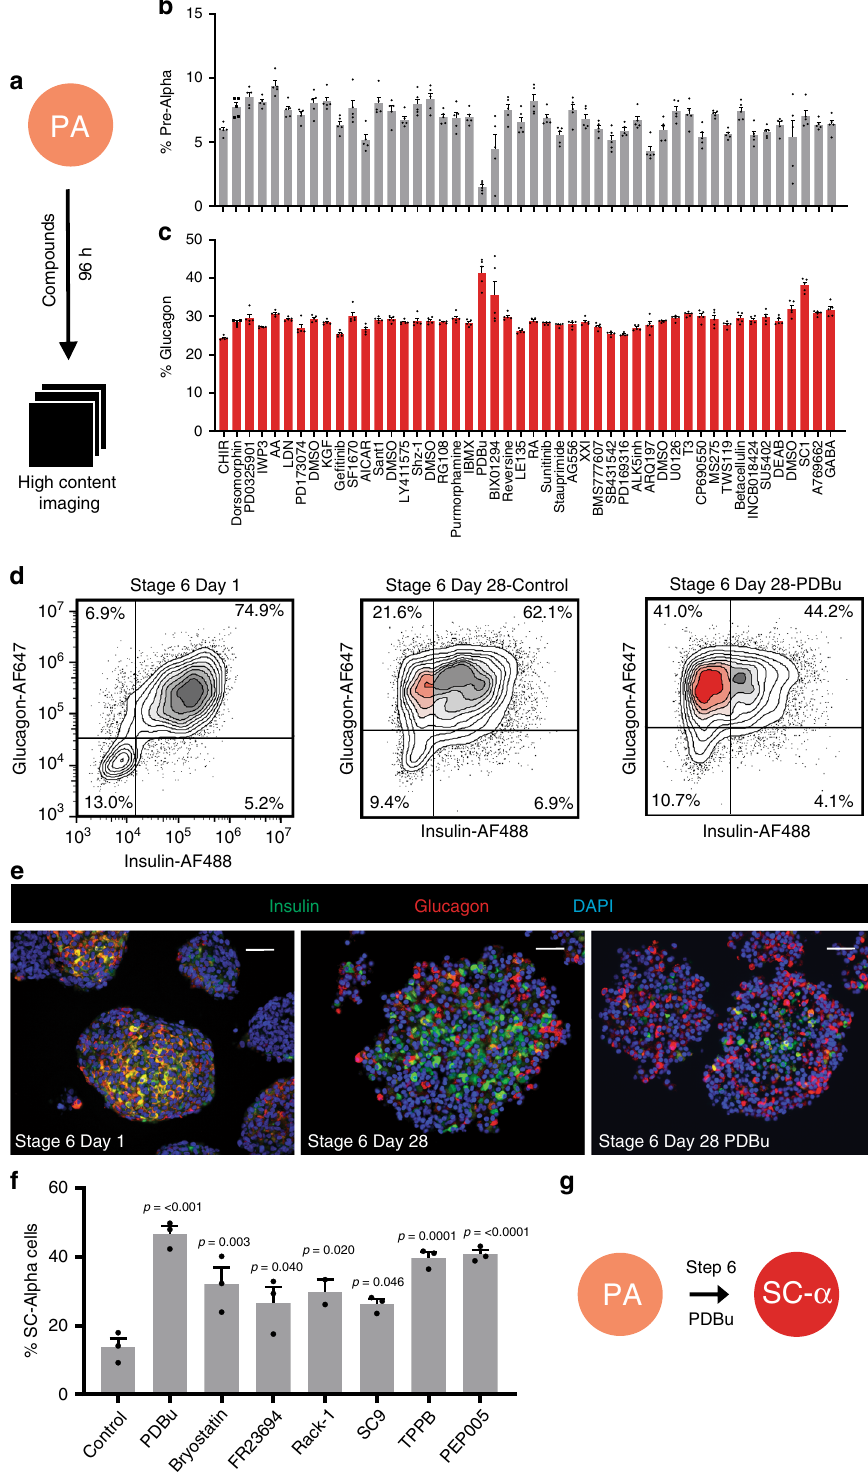
Fig. 3 Screen to identify compounds that promote alpha cell identity. Small molecules targeting known pathways (43 compounds) were incubated with pre- alpha cells in quintuplicate for 96h. a Schematic of screening approach. Primary screening results showing b the percentage of cells expressing both insulin and glucagon and c the percentage of cells expressing only glucagon. The data are presented as mean±SEM ( n = 5 biologically independent samples). The PKC activator PDBu signi fi cantly reduced the percentage of pre-alpha cells and increased the percentage of cells expressing glucagon. d Representative fl ow cytometry results of pre-alpha cells at stage 6 day 1, and stage 6 day 28 control (no treatment), or 28 days treatment with the PKC activator PDBu. e Immuno fl uorescence of clusters treated with and without PDBu for 28 days. Scale bar = 50 μ m. f Additional PKC activators evaluated for their effect on pre-alpha cells (stage 6 day 1). All PKC activators increased the percentage of SC-alpha cells. The data are presented as mean±SEM, signi fi cance calculated using an ordinary one-way ANOVA with Dunnett multiple comparison test ( n = 3 biologically independent samples). g Stage 6 of protocol converts pre-alpha cells into SC-alpha